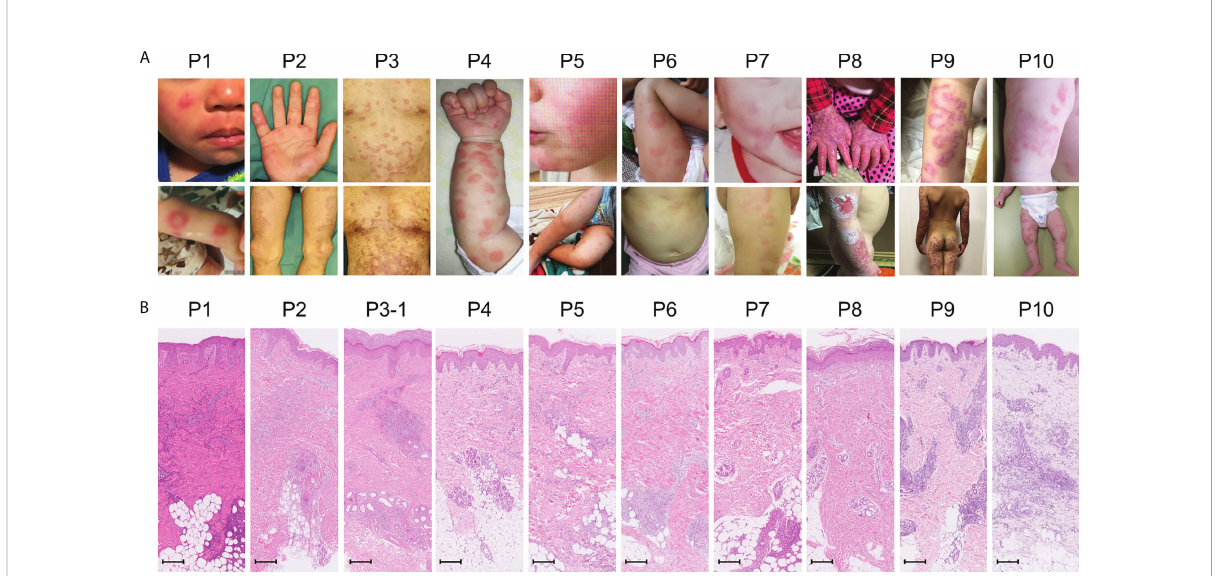
FIGURE 2 Macroscopic skin manifestations in patients with monogenic interferonopathy-like symptoms. Images of the macroscopic skin manifestations for each patient are shown in panel (A) . All patients, with the exception of P8, displayed nodular erythema. These lesions were palpable, sometimes annular, erythematous or violaceous plaques that healed with residual purpura (refer to the lower pictures for P2 and 3). P8 presented with livedo reticularis and skin ulcers. Panel (B) shows H&E-stained sections from the skin lesions. In all patients, with the exception of P7 and P8, mononuclear in fi ltrates in the perivascular and periadnexal dermis were seen. The mononuclear in fi ltrates in P7 were more intense in deep adipose tissues. Epidermal and super fi cial dermal in fi ltrates were observed in P8. The scale bar shown represents 200 m